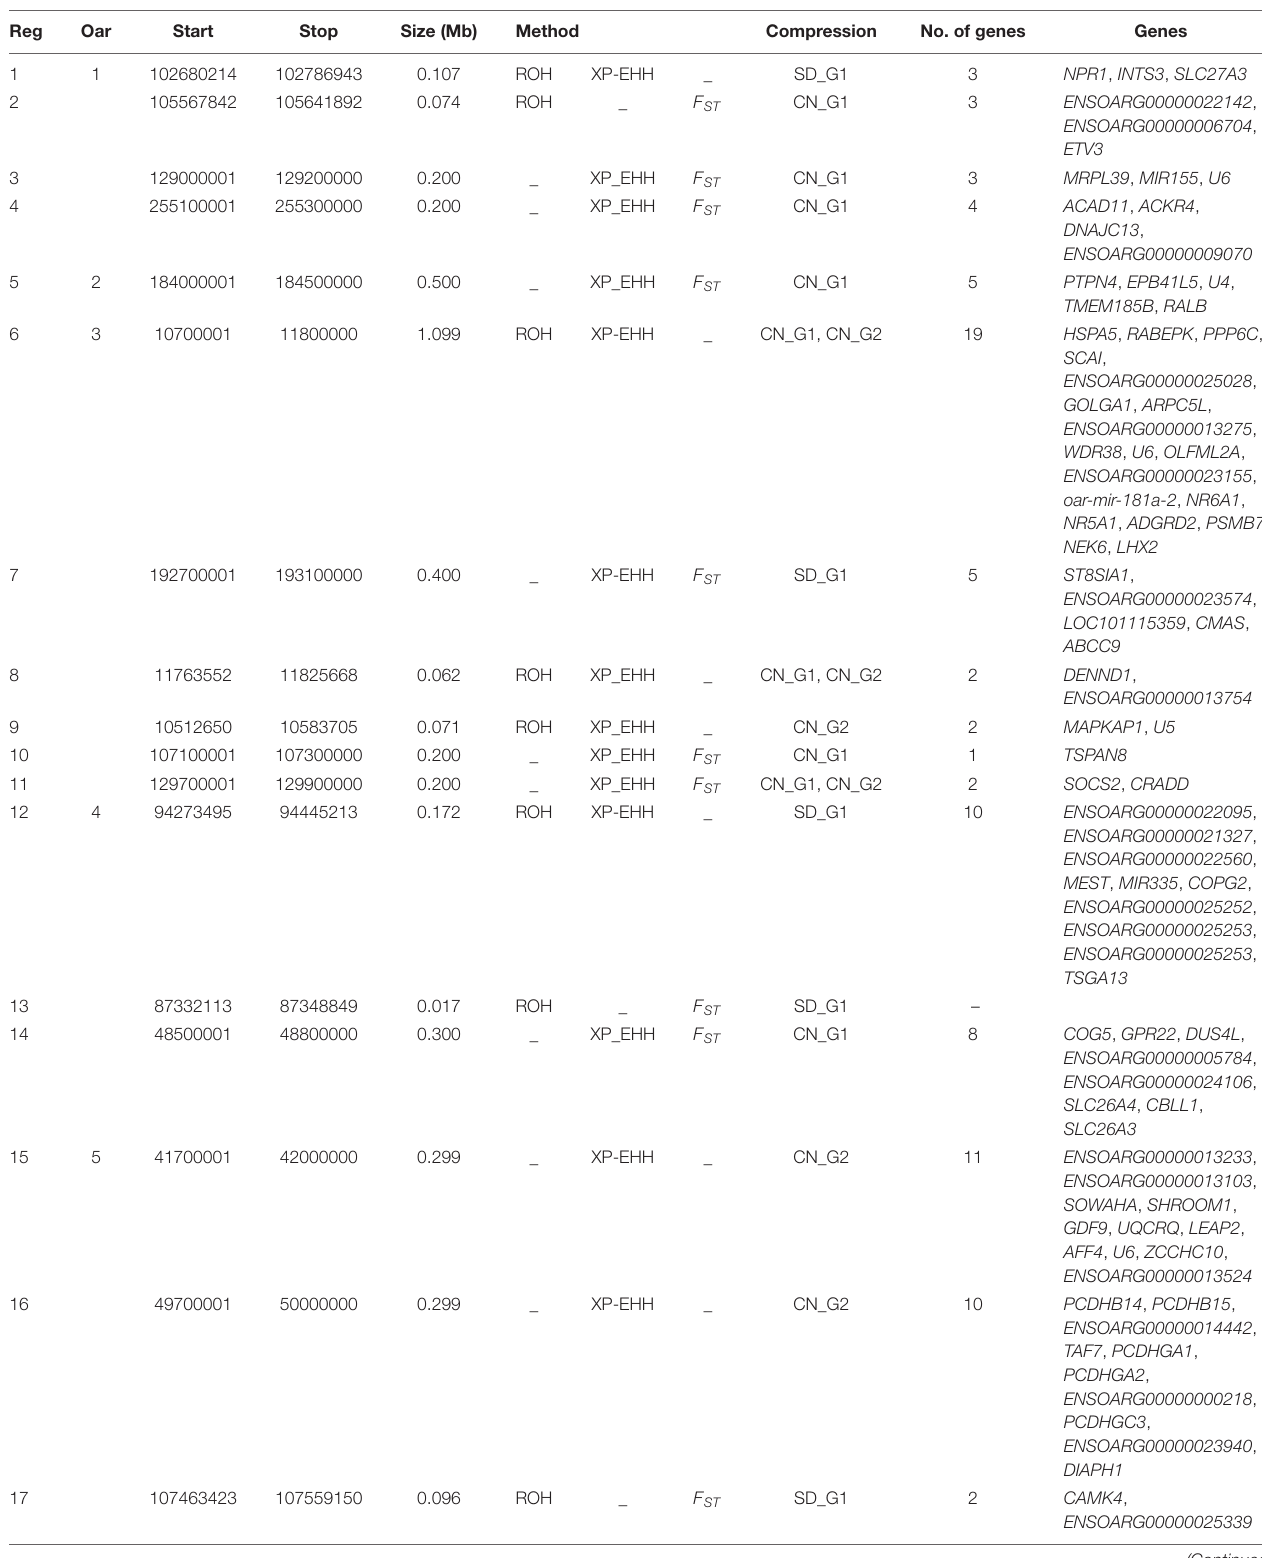
TABLE 3 | Candidate regions detected by at least two approaches of selection signature analysis in the SD_G2 sheep group. Reg